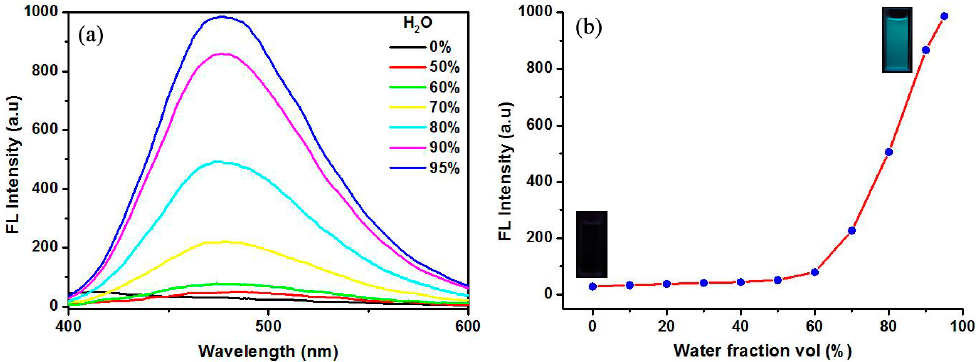
Figure 1. ( a ) Fluorescence emission spectra for solution of TPE-2triazole-2CD (50 μ M) in different ratios of DMSO/H 2 O ( λ ex = 330 nm, ex/em slits = 5/5); ( b ) Fluorescence response of the sensor (50 mM) in different solvent compositions of H 2 O/DMSO at 475 nm ( λ ex = 370 nm).